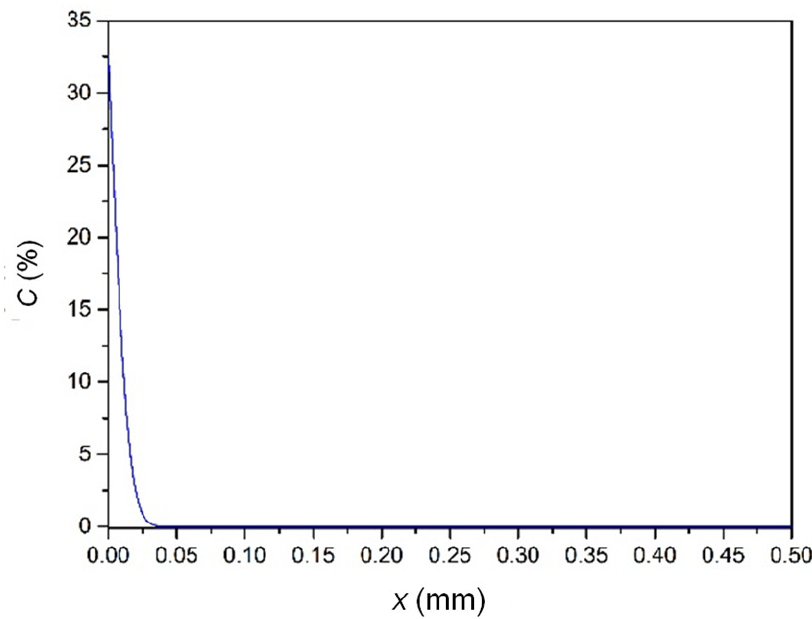
Figure 9. Fitting curves at room temperature for 2000 years.